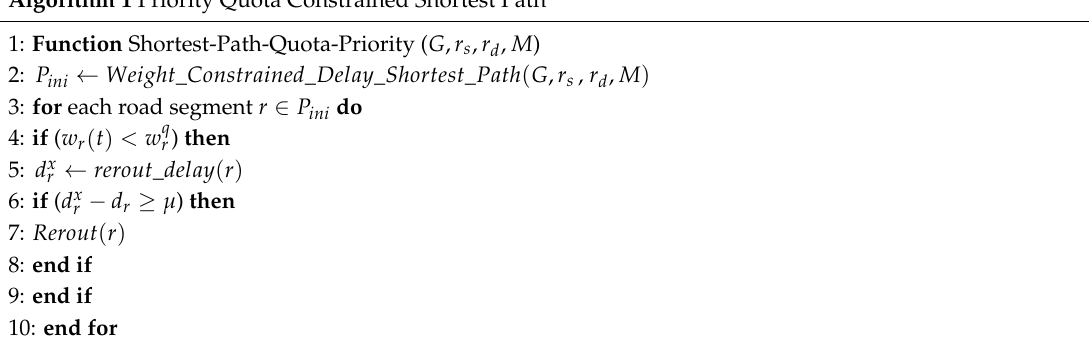
Algorithm 1 Priority Quota Constrained Shortest Path